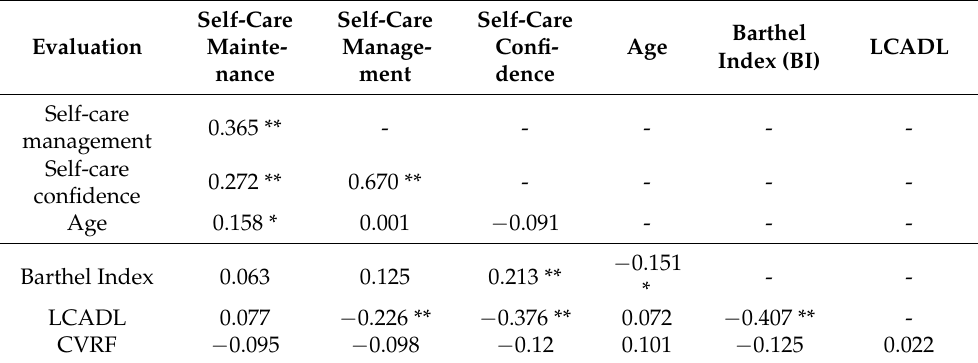
Table 5. Pearson Correlations test (r) between numeric variables (N =